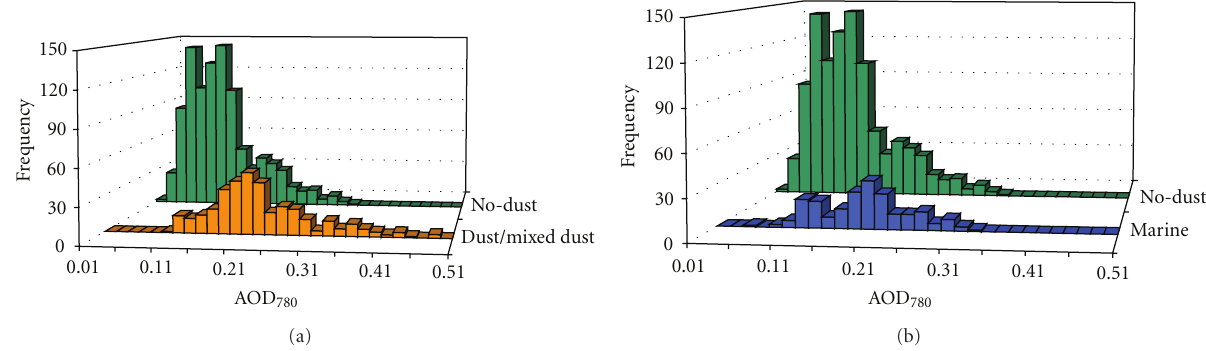
Figure 1: Histograms of AOD at 780 nm (a) comparing dust/mixed dust and no-dust data and (b) comparing no-dust and marine data.